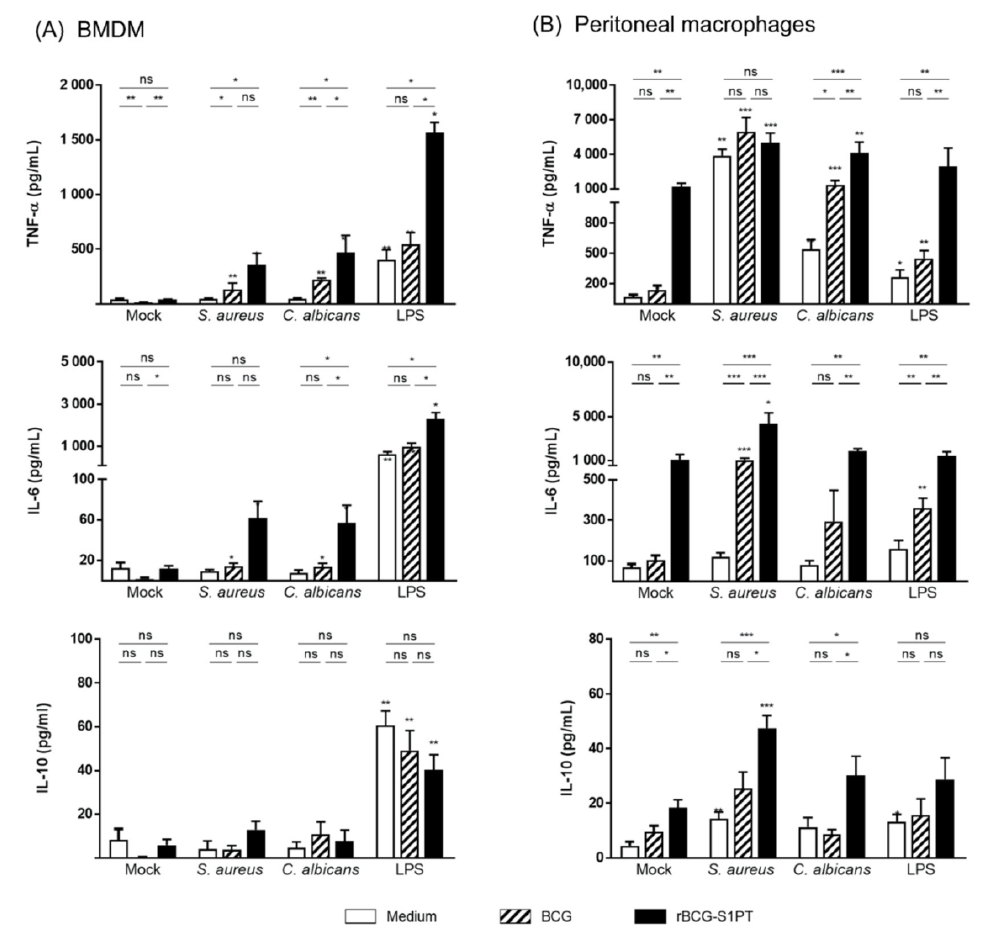
Figure 3. Memory response of primed macrophages to heterologous challenges. BMDM ( A ) and peritoneal macrophages ( B ) from naïve mice were exposed in vitro to culture medium alone (un- primed, white bars), BCG (striped bars), or rBCG-S1PT (black bars) (MOI 0.1:1) for 24 h. Cells were then left to rest for 6 days and re-stimulated with medium alone (mock) or with S. aureus , C. albicans , or LPS (horizontal axis). The production of TNF- α (upper panels), IL-6 (middle panels), and IL-10 (lower panels) was measured after 24 h. Statistical analysis was performed via Mann–Whitney U